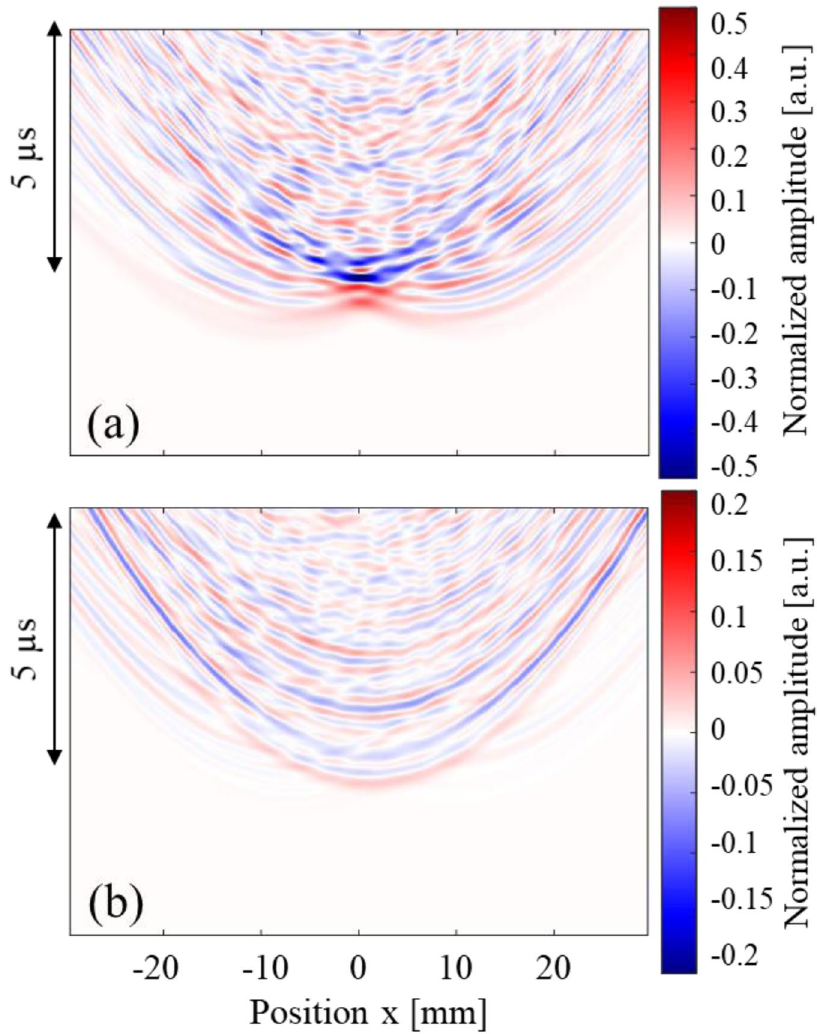
Figure 10. Maximum amplitudes of the observed pulse waves (sample C, BV/TV = 50%). ( a ) Cancellous part was filled with water. ( b ) Cancellous part with no